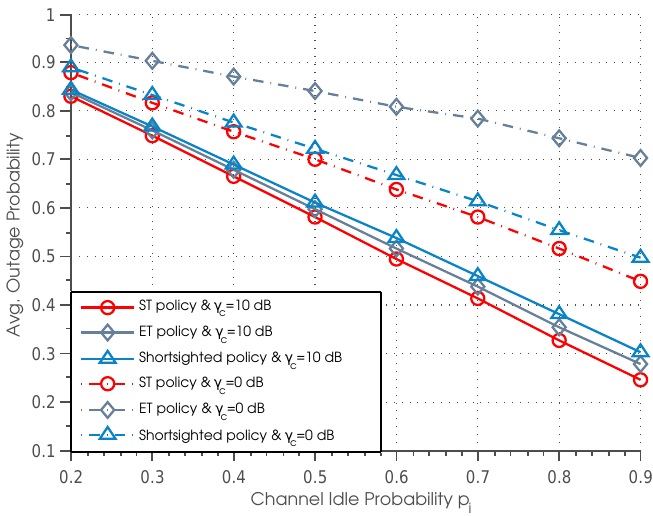
Figure 3. Average outage probability vs. normalized SNR.